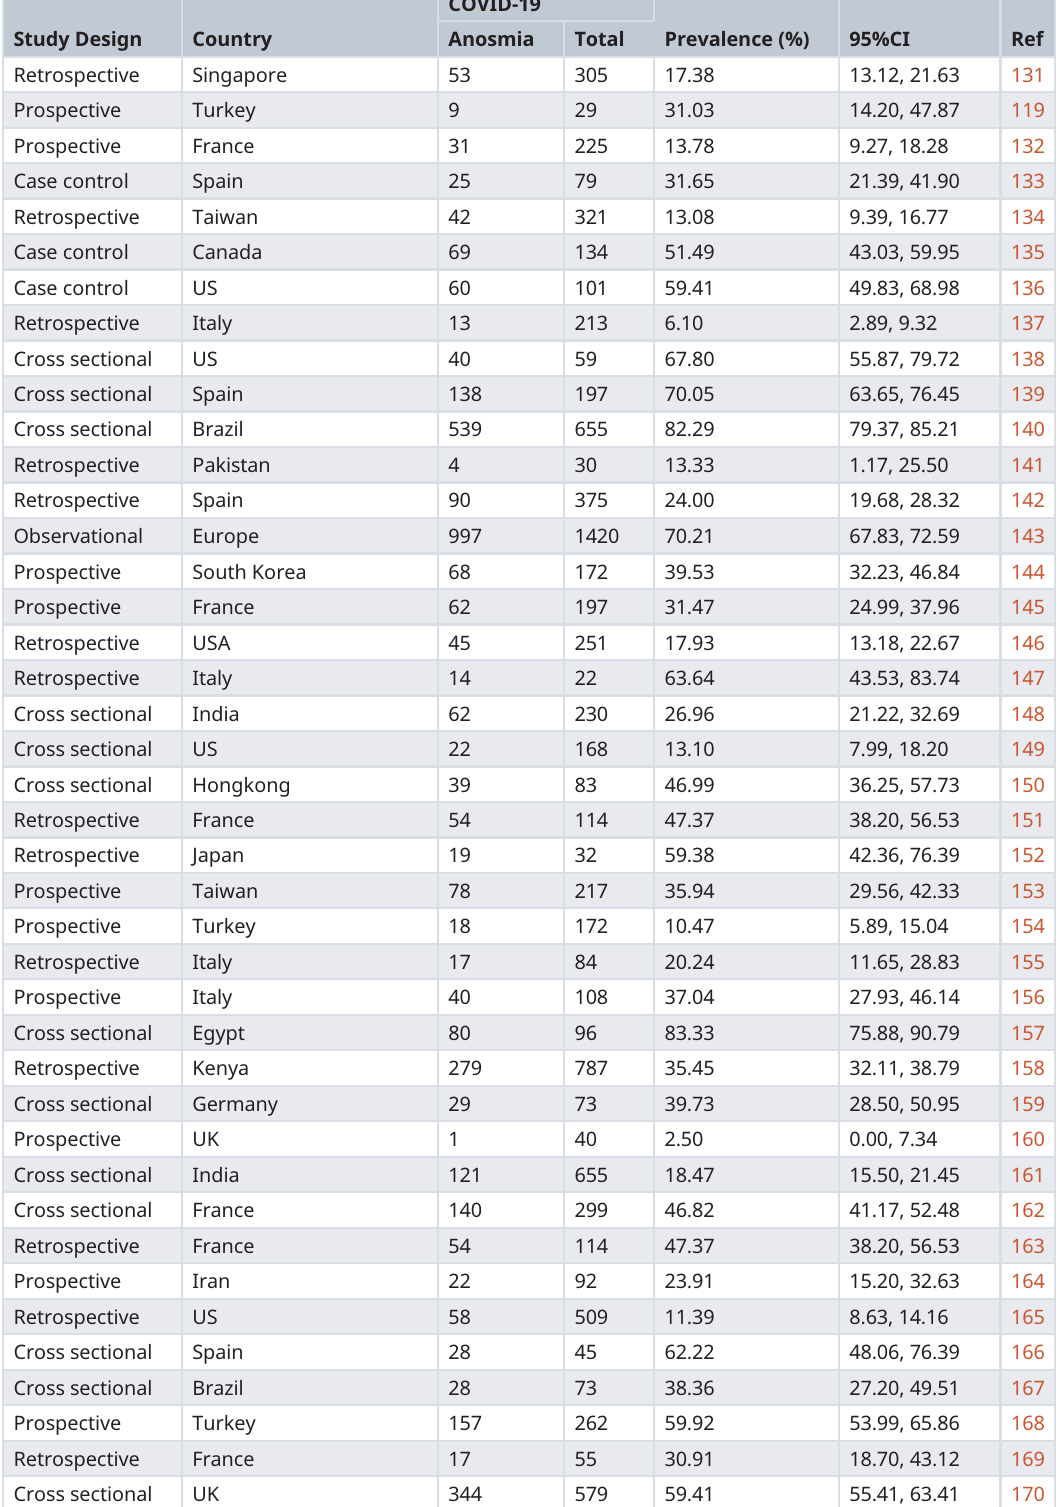
Table 1. The prevalence of anosmia among COVID-19 patients around the globe.